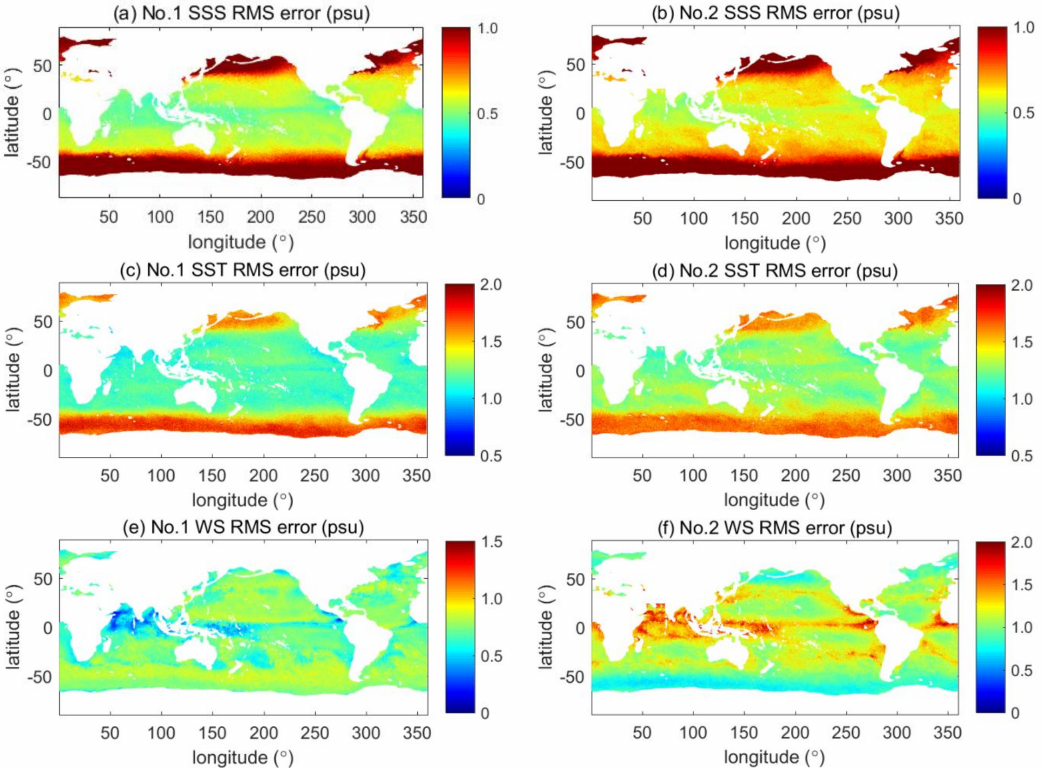
Figure 5. The errors on the retrieved SSS, SST, and WS with default configuration and with default configuration except the 1.26 GHz scatterometer of MICAP during only one satellite pass: SSS ( a ); SST ( c ); and WS ( e ) errors with No. 1 configuration; and SSS ( b ); SST ( d ); and WS ( f ) errors with No. 2